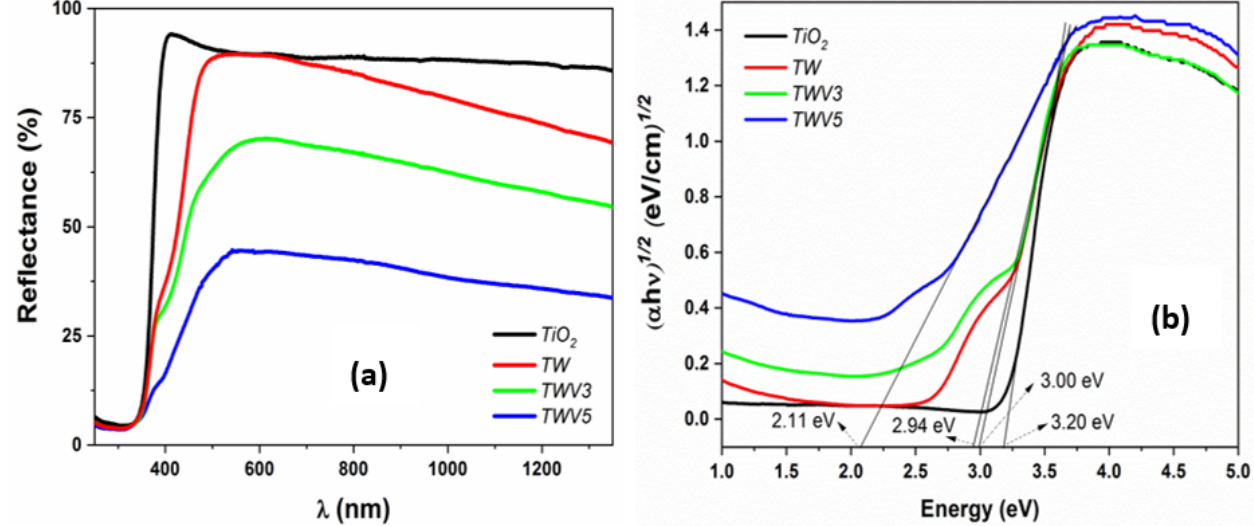
Figure 6. ( a ) DRS data and ( b ) Tauc plot for bandgap measurements of the nanostructured metal